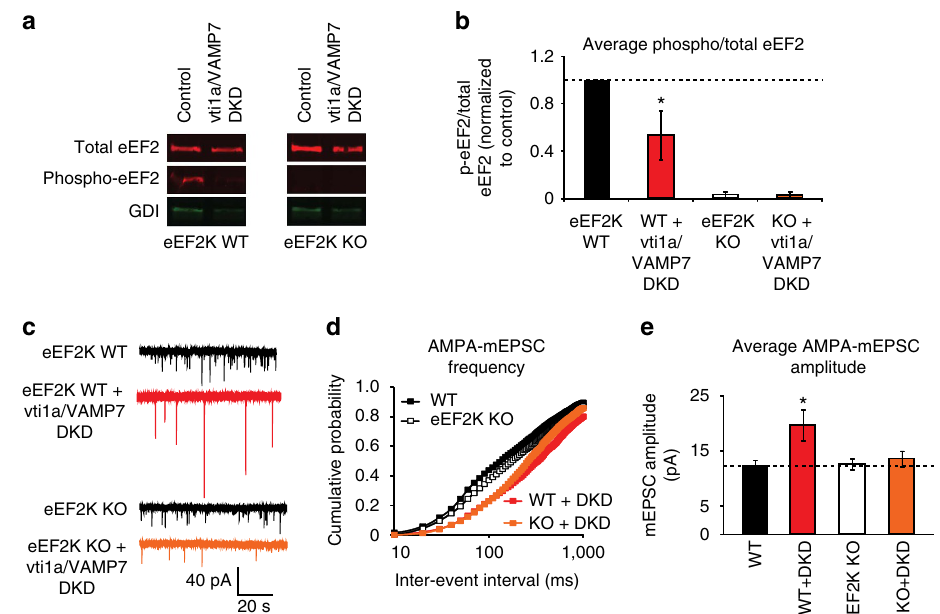
Figure 4 | Synaptic scaling of AMPA-mEPSC amplitudes requires eEF2 kinase. ( a ) Representative immunoblots showing total eEF2, phospho-eEF2 and loading control (GDI) levels in neuronal protein samples collected from WT and eEF2K KO sibling littermate neurons with or without vti1a/VAMP7 DKD. The break between genotypes represents the removal of irrelevant lanes from the full western blot image. ( b ) Quantitation of phospho-eEF2 levels compared with total eEF2 levels after normalization to the loading control ( n ¼ 4 independent cultures). Vti1a/VAMP7 DKD decreased phospho-eEF2 levels in WT neurons (corrected P o 0.05) while no phospho-eEF2 is observed in eEF2K KO neurons, as expected. ( c ) Representative traces of AMPA-mEPSC recordings in control or vti1a/VAMP7 DKD neurons from WT littermate or eEF2K KO mouse cultures. ( d ) Cumulative probability histograms of AMPA-mEPSC inter-event intervals (WT: n ¼ 12 neurons from three independent cultures; WT þ vti1a/VAMP7 DKD: n ¼ 6 neurons from three independent cultures; eEF2K KO: n ¼ 13 neurons from three independent cultures; eEF2K KO þ vti1a/VAMP7 DKD: n ¼ 14 neurons from four independent cultures). Vti1a/VAMP7 DKD significantly decreased the number of high-frequency AMPA-mEPSC events in both eEF2K WT and eEF2K KO neurons (Kolmogorov–Smirnov test; corrected P o 0.001, WT versus WT þ vti1a/VAMP7 DKD; corrected P o 0.001, eEF2K KO versus eEF2K KO þ vti1a/VAMP7 DKD). ( e ) Average AMPA-mEPSC amplitudes from data analysed in d . A significant increase in AMPA-mEPSC amplitude was seen in WT neurons with vti1a/VAMP7 DKD but not in eEF2K KO neurons (WT versus WT þ vti1a/VAMP7 DKD, corrected P o 0.05; eEF2K KO versus eEF2K KO þ vti1a/VAMP7 DKD, corrected P 4